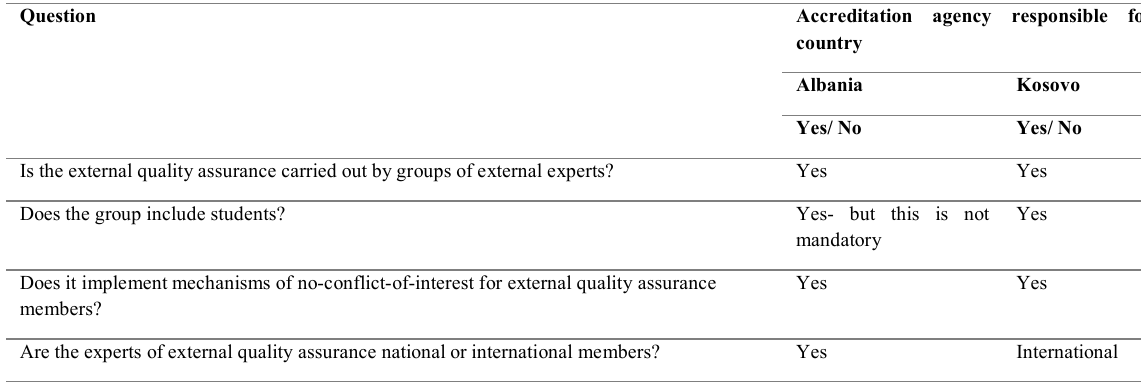
Table 18: External quality assurance: Group of external experts (KAA and